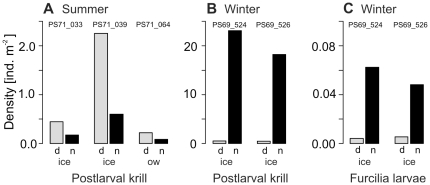

Euphausia superba.Day/night comparisons of the surface layer density of (A) postlarval krill at three locations in summer (2007/2008), (B) postlarval krill, and (C) furcilia larvae at two locations in winter (2006). Scaling of y-axis differs. Denotations above bars are location codes. d = daytime, night = night-time; ice = under-ice, ow = open water SUIT hauls.